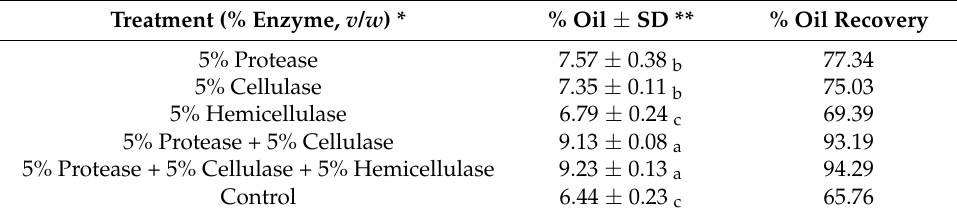
Table 3. Effects of different enzymes (in single and combination) on oil recovery from original